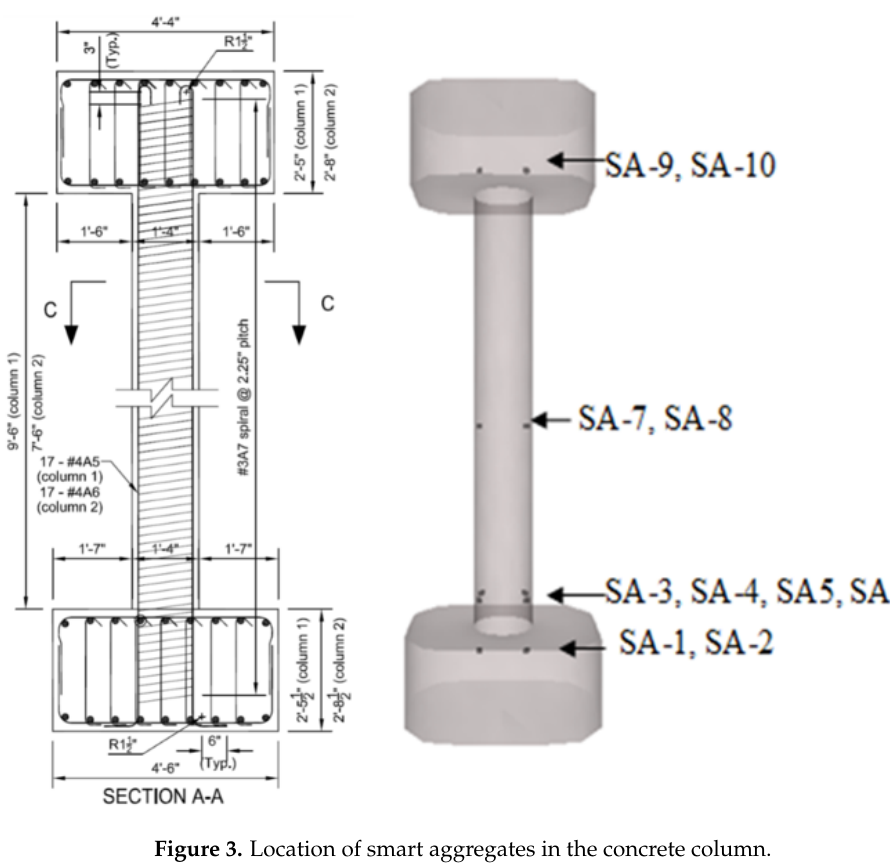
Figure 3. Location of smart aggregates in the concrete column.